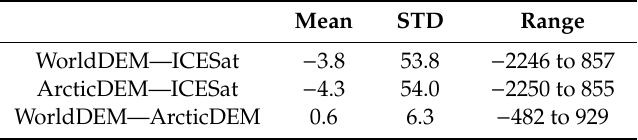
Table 3. Relative accuracy of ICESat-1 data over Iceland, compared to WorldDEM and ArcticDEM. No artifacts were removed (number of points =